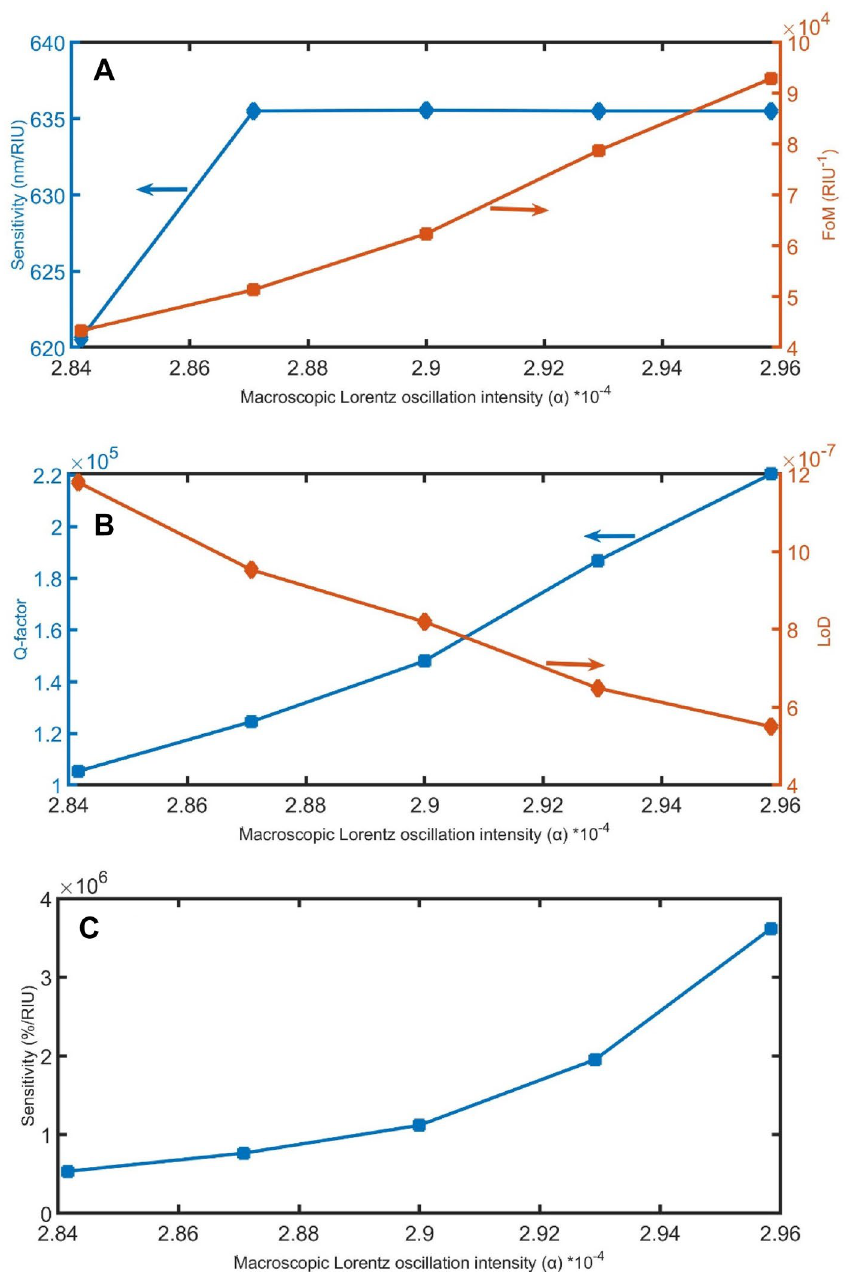
Figure 13. The ( A ) sensitivity in nm/RIU and FoM, ( B ) Q-factor and LoD, and ( C ) sensitivity in %/RIU, with varying the